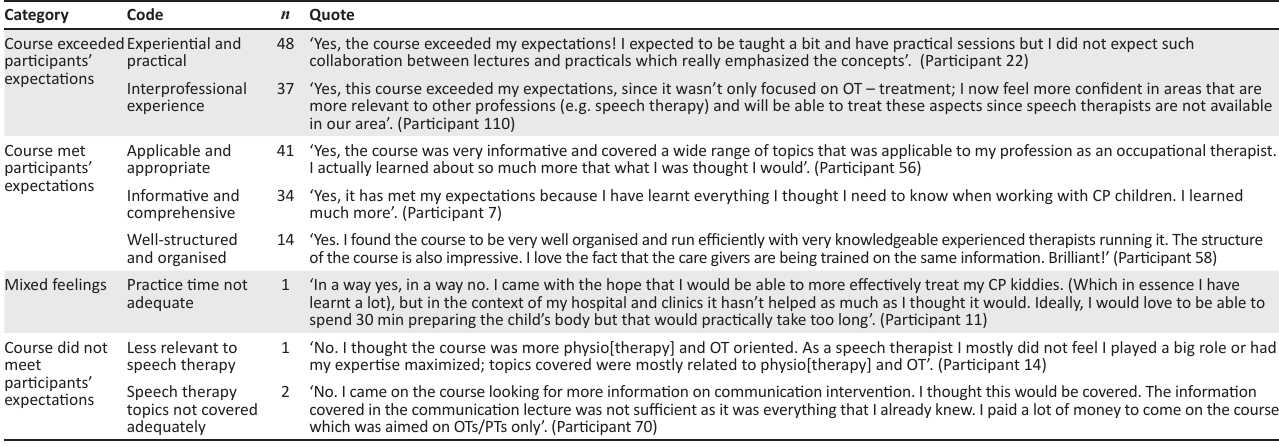
TABLE 2: Participants’ expectations of the course. Category